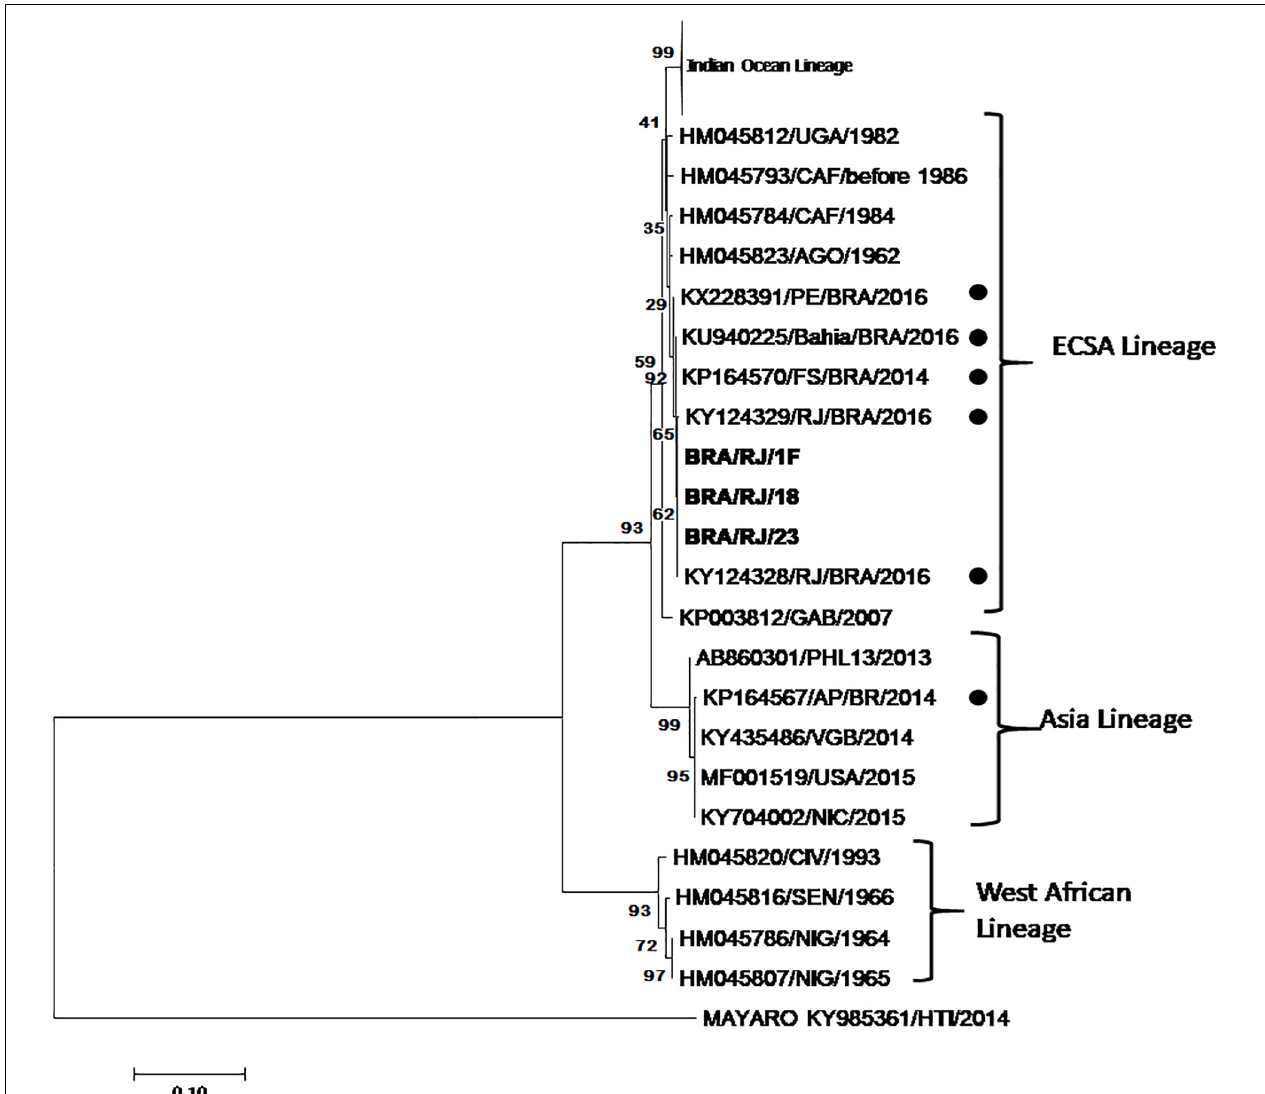
FIGURE 1 | Phylogenetic tree was construct for partial non-structural protein (710 pb). Performed by using the Maximum Likelihood method based on the Kimura 2-parameter model. The analysis involved 69 nucleotide sequences. One fragment of sequences described in this studied is in bold, BRA/RJ/1F, BRA/RJ/18, and BRA/RJ/23 (GenBank access numbers MK910738; MK910739; MK910740). Dots mark the Brazilian